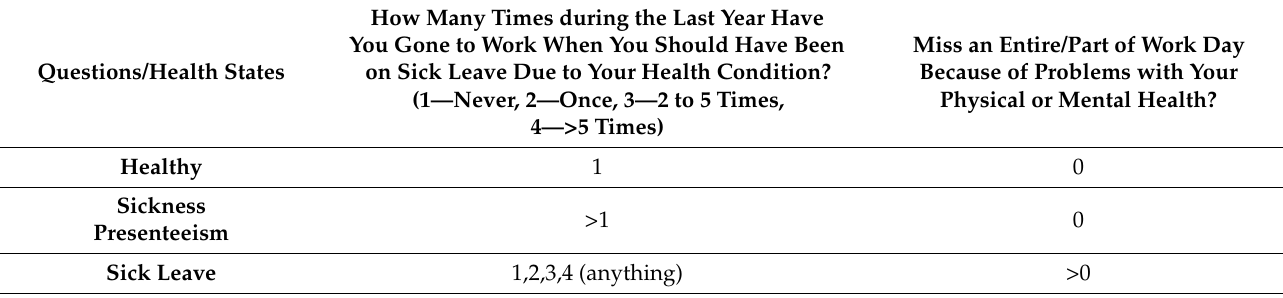
Table 1. Calculation of mean productivity loss percentage and